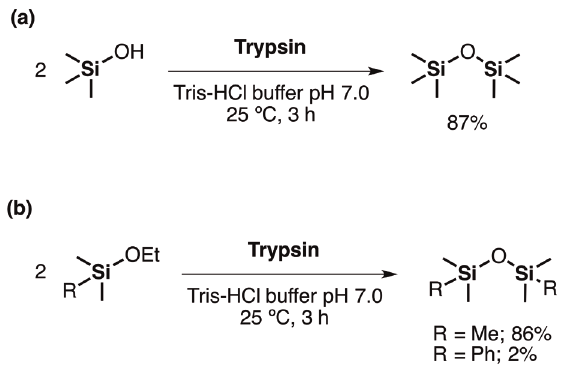
Figure 55 - Trypsin-catalyzed siloxane bond